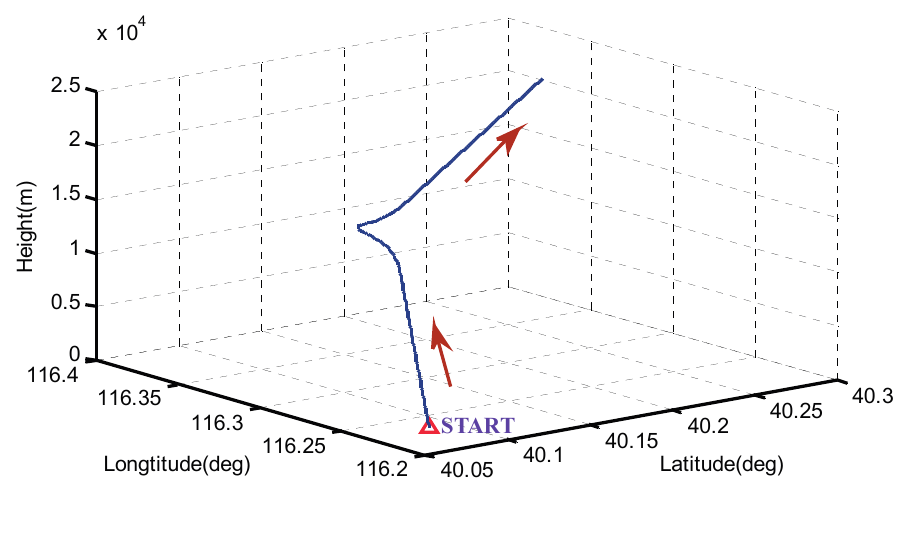
Figure 2. The 3-D trajectory of the